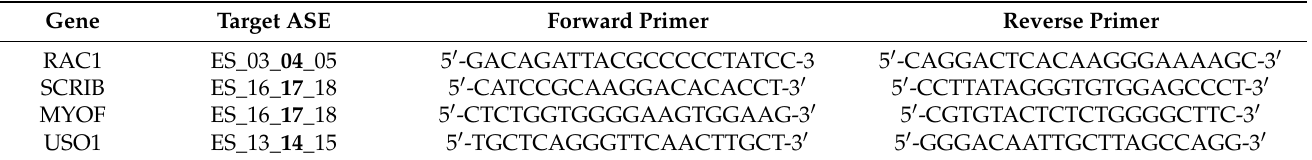
Table 1. Primers used for the qPCR validation of target